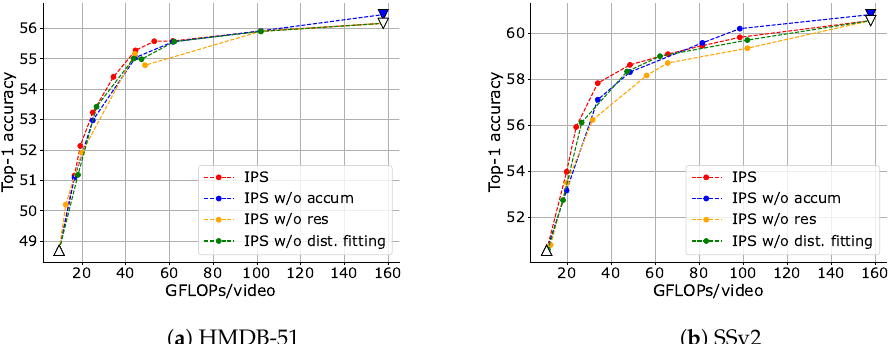
Figure 8. Trade-offs between top-1 accuracy and inference cost adjusted via IPS and IPS without each element. Here, ”accum” stands for P-frame accumulation, ”res” for residuals and ”dist. fitting” for distribution fitting. The data point with the highest FLOPs for each setting is obtained when no input reduction is performed (upper bound), and the data point with the lowest FLOPs is obtained when only I-frames are input (lower bound). The upper and lower bounds are plotted as inverse triangles and triangles, respectively. In these comparisons, the upper bound is the same for ”IPS”, ”IPS w/o res” and ”IPS w/o dist. fitting”, and the lower bound is the same for all settings. They are plotted as a white-filled inverted triangle and a triangle,